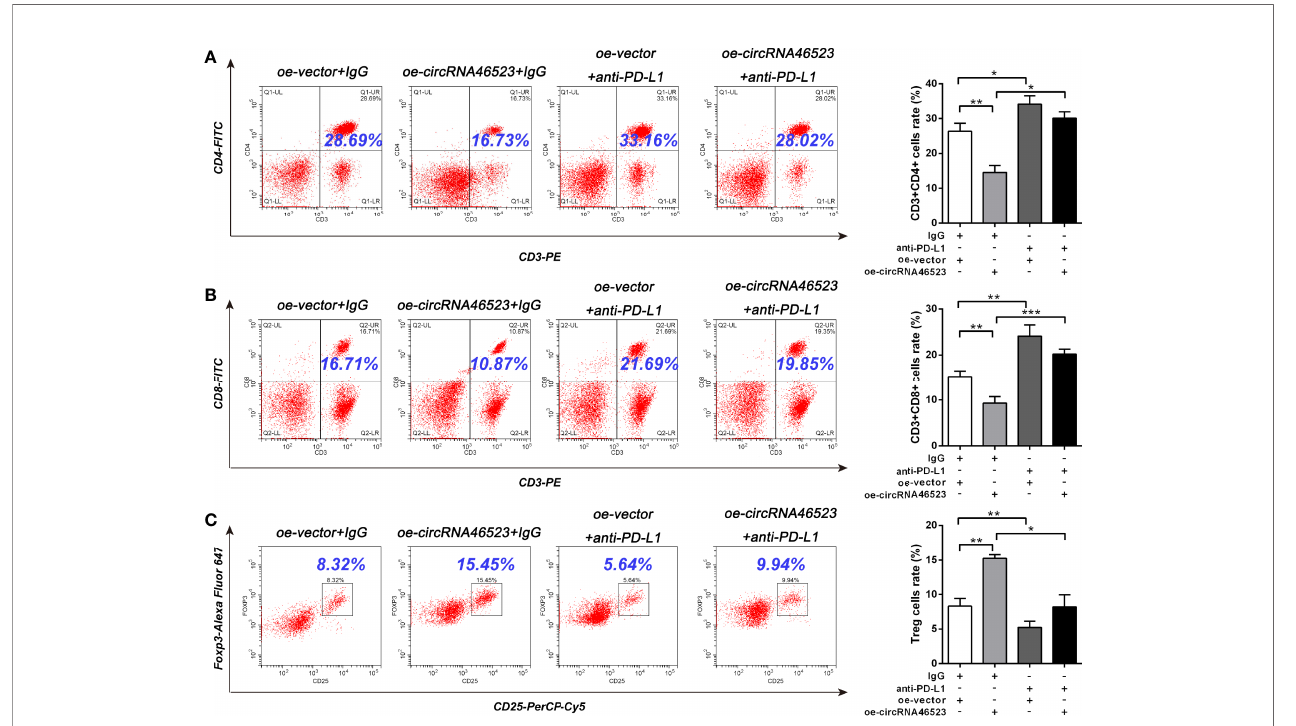
FIGURE 6 | Hsa_circ_0046523 regulated the proportion of CD4 + T cells, CD8 + T cells and Tregs in PBMCs via PD-L1. PC cells with hsa_circ_0046523 overexpression were co-cultured with PBMCs, and PD-L1 neutralizing antibody (anti-PD-L1) was added to the co-culture system. (A – C) Flow cytometry analysis of the proportion of CD4 + , CD8 + T cells and Tregs in PBMCs after co-culture. Data were expressed as means ± SD of three independent experiments. * P < 0.05, ** P < 0.01, *** P <